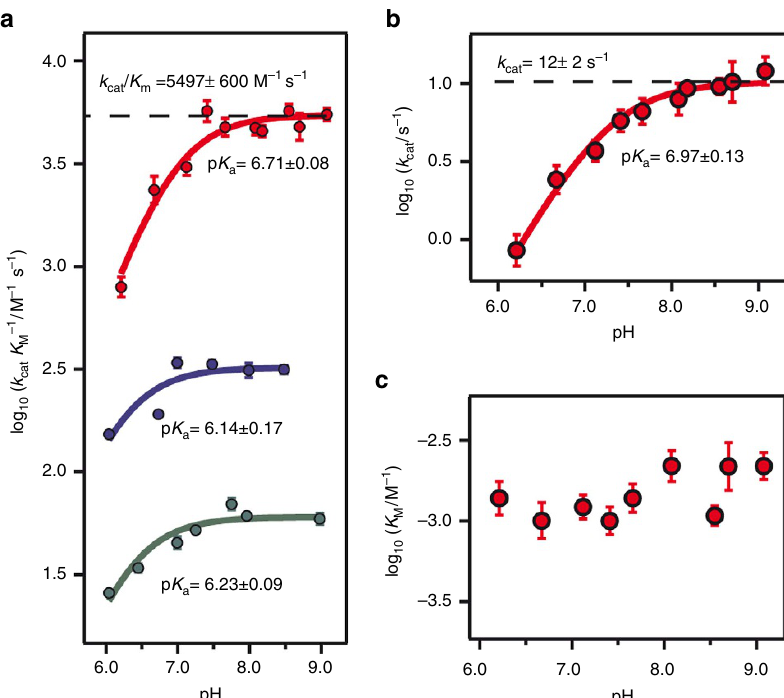
Figure 5 | pH dependence of the de novo Kemp eliminases. ( a ) Plot of catalytic efficiency ( k cat / K M ) versus pH. ( b ) Plot of turnover number ( k cat ) versus pH. ( c ) Plot of the Michaelis constant ( K M ) versus pH. The data shown are derived from the fitting of the Michaelis–Menten equation to the experimental profiles of rate versus substrate concentration. Error bars stand for the s.d.’s of the fitting parameters as provided by the fitting program used (Igor Pro 6.37). The colour of the data points refers to the b -lactamase variant studied, specifically: GNCA MP -W229D (green); GNCA 3 -W229D (blue); GNCA 4 -W229D/F290W (red). The continuous lines in ( a , b ) represent the best fits of equation (1) to the experimental data. The p K values determined from such fits are shown alongside the lines, together with the standard errors derived from the fittings. The high pH limiting values for our best Kemp eliminase, GNCA 4 -W229D/ F290W, are shown as dashed lines. K M values for this variant (shown in c ) appear to be essentially